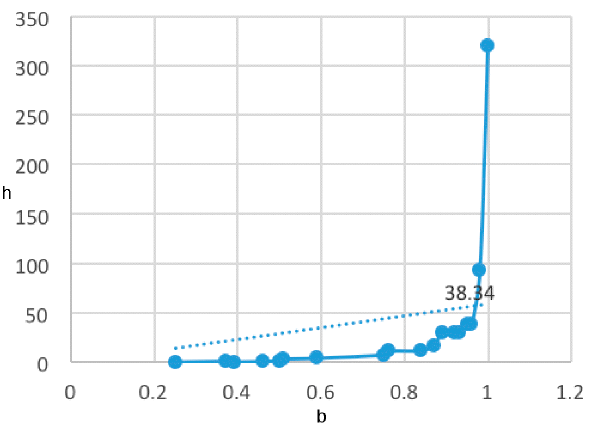
Figure 3. Entropy h vs. classification level b for different numbers of classes.